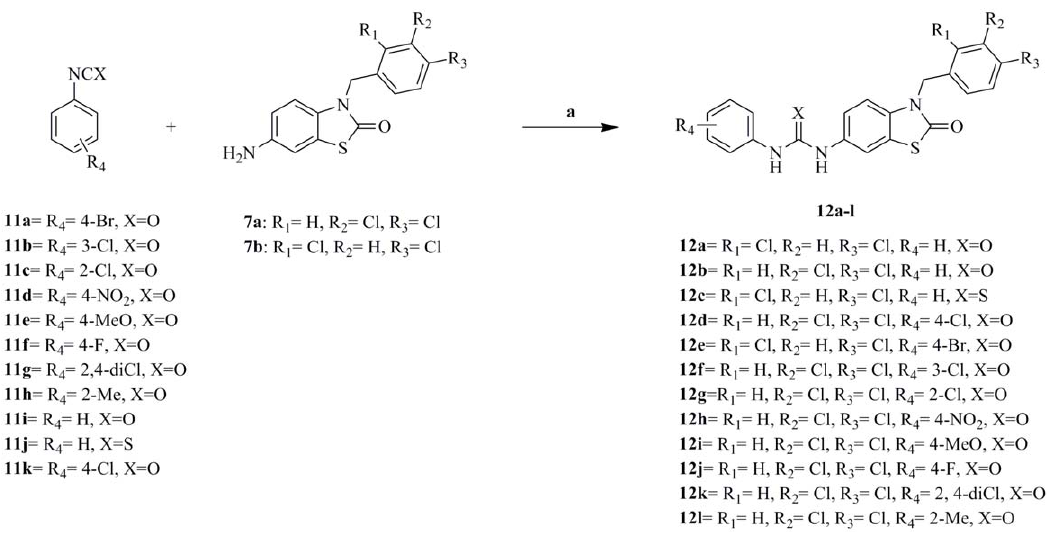
Figure 13. Synthesis of target compounds (12a–l). Reagents and conditions: (a) CH 2 Cl 2 , r.t, overnight.